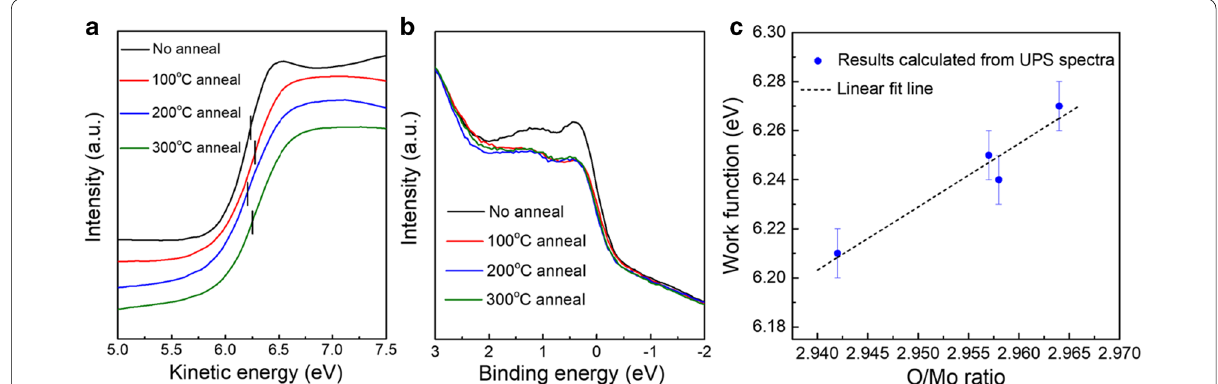
Fig. 4 a The secondary electron cutoff region and b valence band from the UPS spectra of the post-annealed MoO X films on silicon wafers. c Work function plotted against the stoichiometry (O/Mo